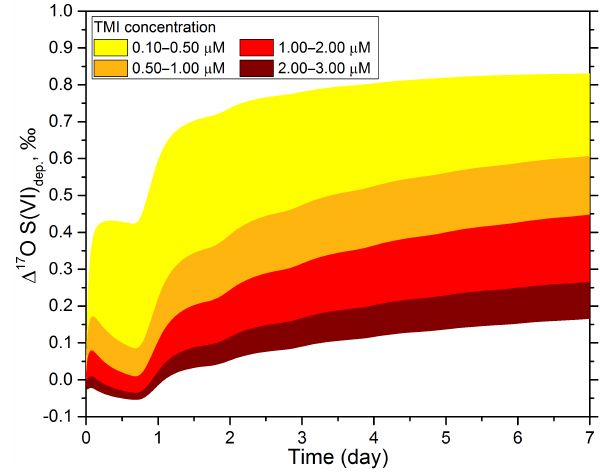
Figure 11. Temporal evolution of (cid:49) 17 O(S ( VI ) ) dep . at different con- centrations of TMI in aqueous solution. Other initial parameters were set: LWC = 1.0 gm − 3 and [SO 2 ] 0 =